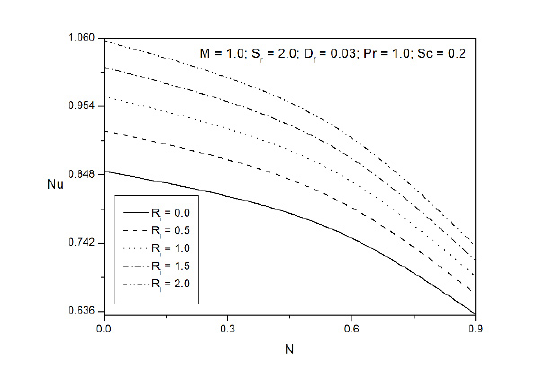
Figure 3. Temperature profile for various values of Magnetic param- eter M